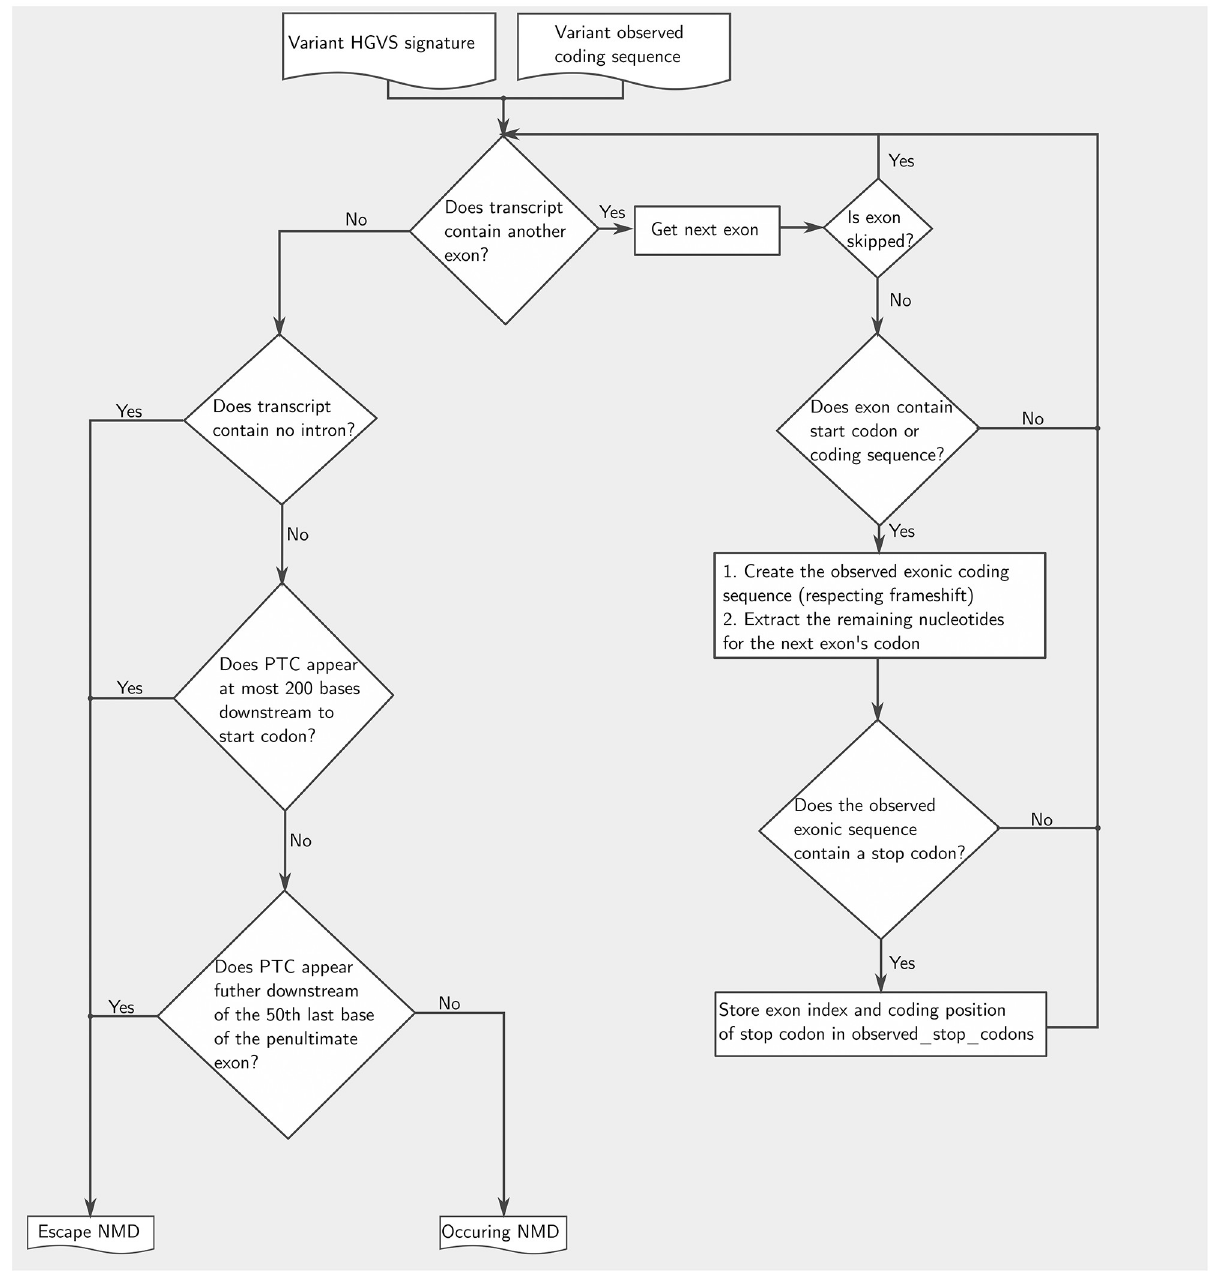
Fig 5. Conceptual flowchart to assess NMD for the refined PVS1